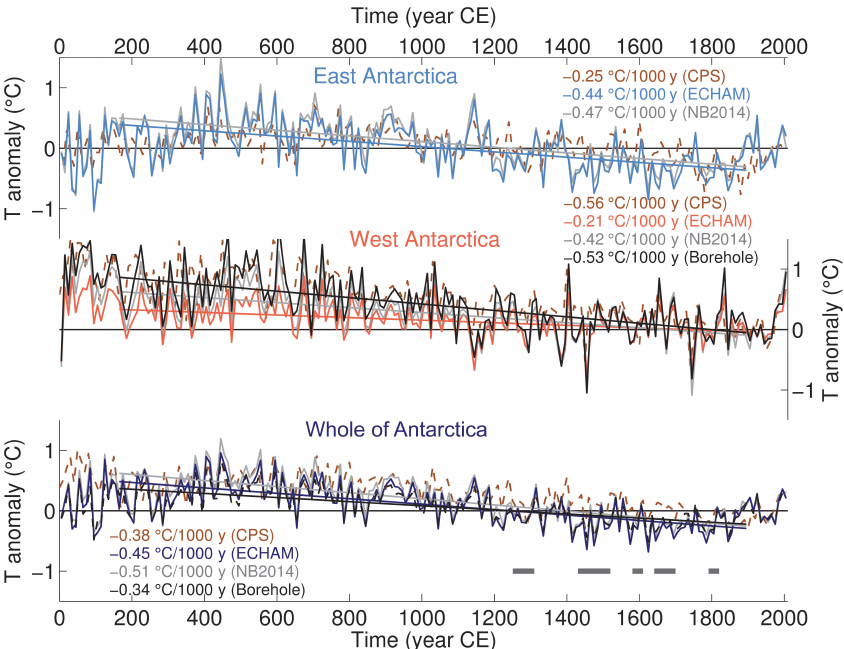
Figure 8. Composite temperature reconstructions ( T anomalies in ◦ C) for East, West and the whole of Antarctica using 10-year averages and the different temperature scaling approaches: dotted coloured lines for the CPS method (2013 method applied to the new database); grey lines for the method that uses the NB2014 variance for scaling (different weighting method compared to CPS); coloured lines for the method based on the correlation between annual mean regional δ 18 O and regional T from ECHAM5-wiso forced by ERA-Interim; black lines for the method adjusted to match the temperature trend between 1000 and 1600CE based on borehole temperature measurements at WAIS Divide (Orsi et al., 2012). Linear trends are calculated between 165 and 1900CE. The grey horizontal segments correspond to volcanic–solar downturn intervals as defined in PAGES 2k Consortium (2013) and corresponding to the following periods: 1251–1310CE, 1431–1520CE, 1581–1610CE, 1641–1700CE and 1791–1820CE.